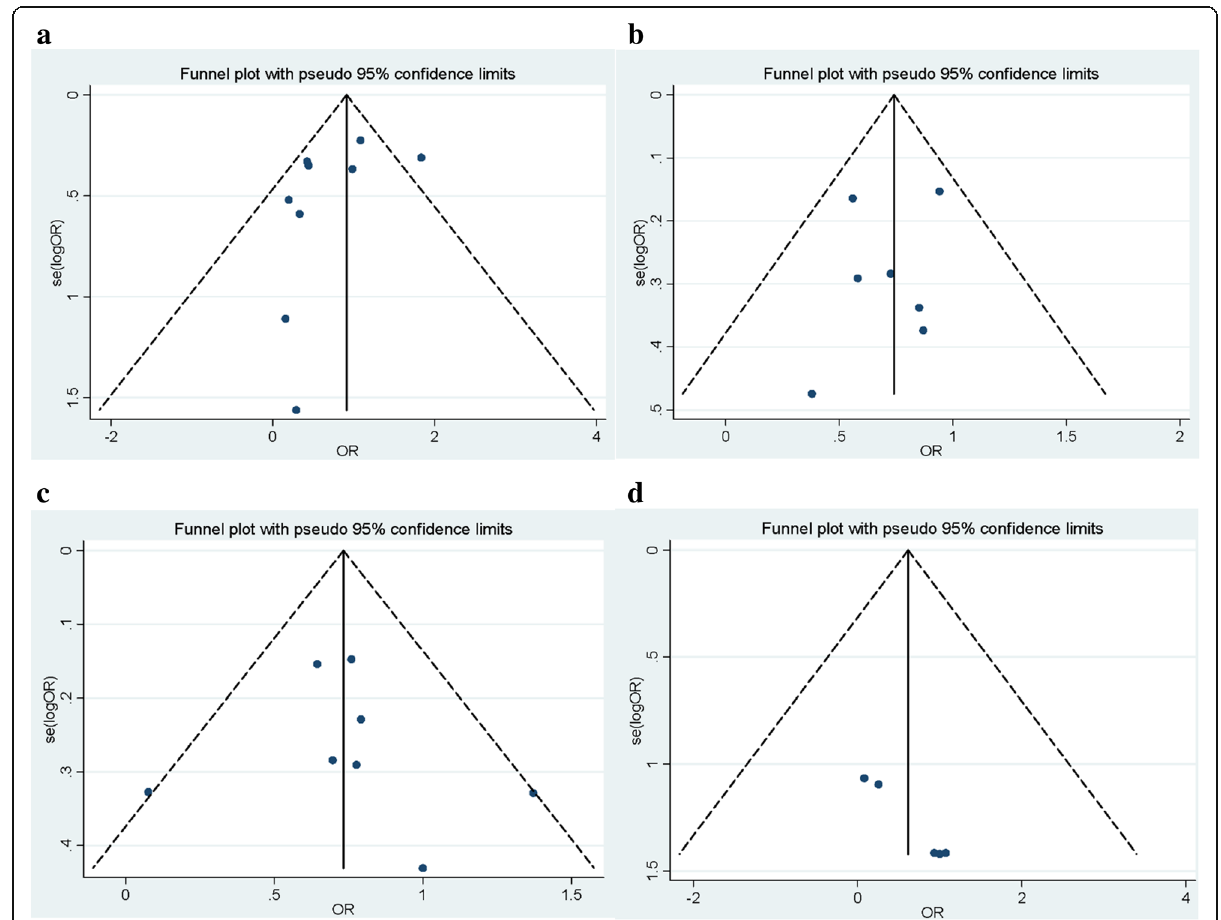
Fig. 4 Funnel plot. The plot displays publication bias and heterogeneity of the results between studies for ( a ) 2DL3, ( b ) 2DL5, ( c ) 2DS5, and ( d ) 3DL3